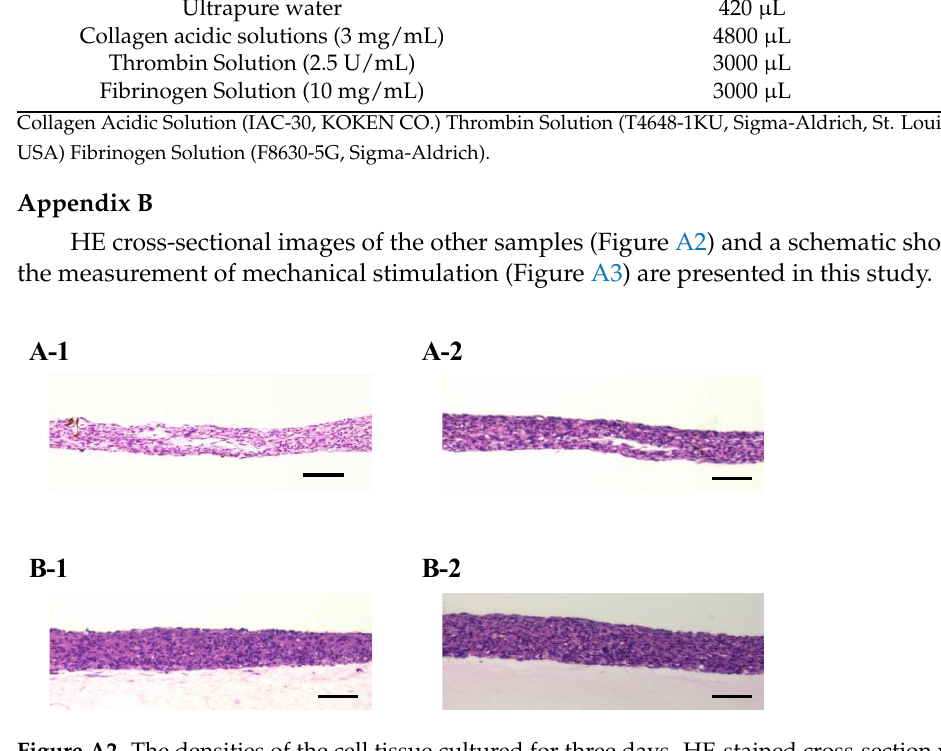
Figure A2. The densities of the cell tissue cultured for three days. HE-stained cross-section views with the cell tissue culture on a general dish ( A ) and collagen gel with a 0.5-mL/min perfusion rate ( B ). Images of 1 and 2 were taken from different samples, and the sample is as shown in Figure 3. Scale bars indicate 100 µm.